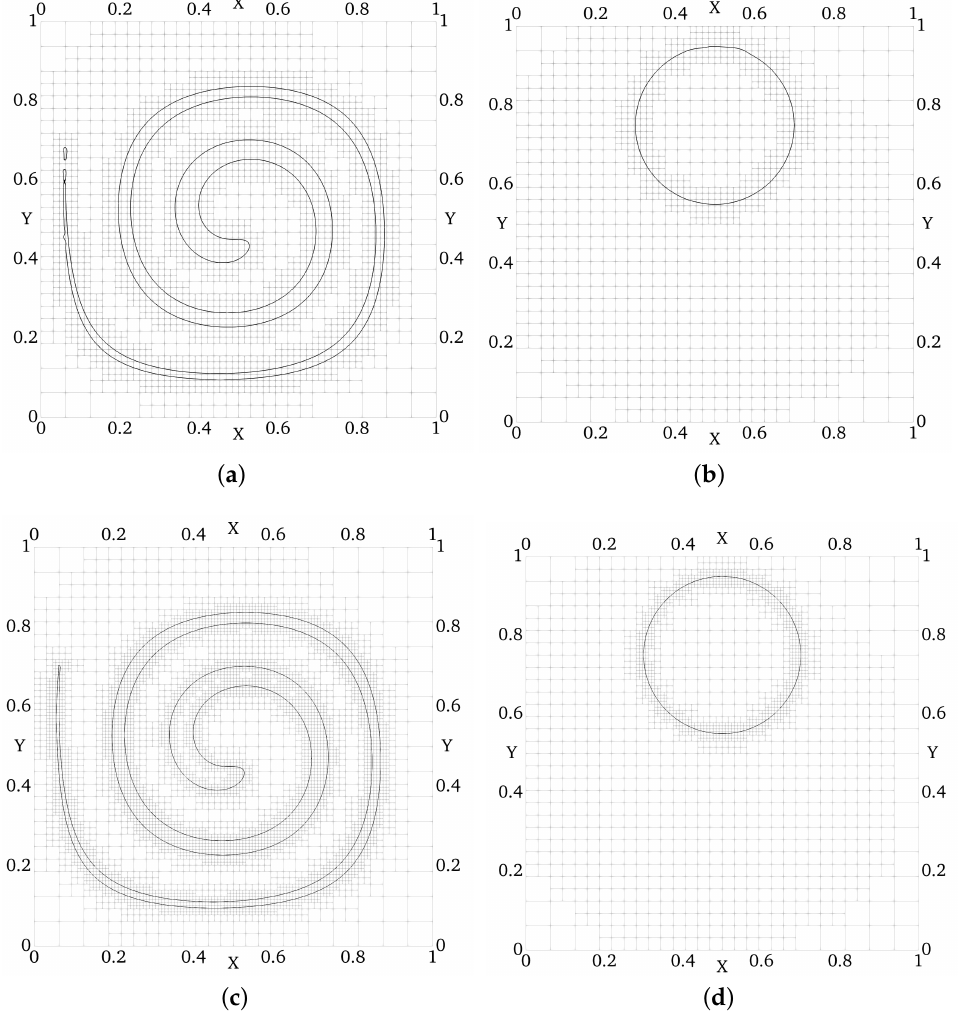
Figure 8. Interface deformation in a 2D single vortex. The reconstructed interface is shown as a black line and the AMR grid is shown as a light gray line. The maximum AMR level and finest resolution of ( a ) and ( b ) are 2 and 256 × 256, respectively. The maximum AMR level and finest resolution of ( c ) and ( d ) are 3 and 512 × 512, respectively. ( a ) t = T , finest resolution 256 × 256. ( b ) t = T , finest 2 resolution 256 × 256. ( c ) t = T , finest resolution 512 × 512. ( d ) t = T , finest resolution 512 × 2